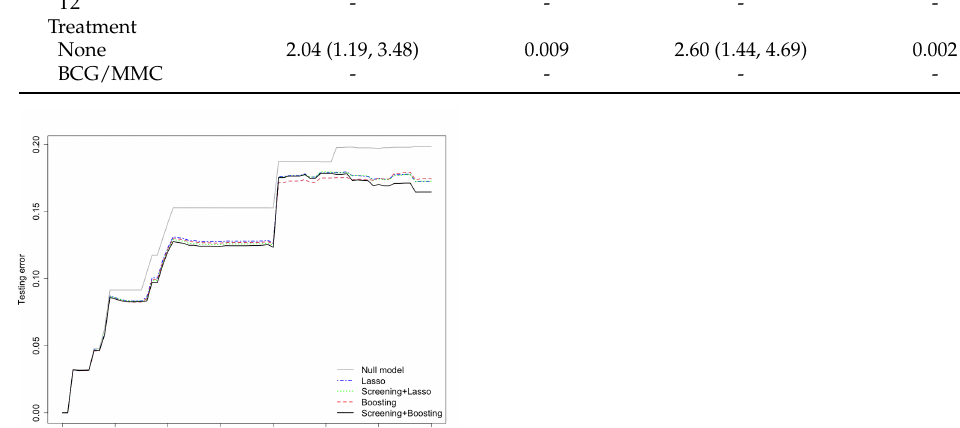
Figure 5. Sensitivity Analysis: testing error curves for the cumulative incidence predicted by the competing models.